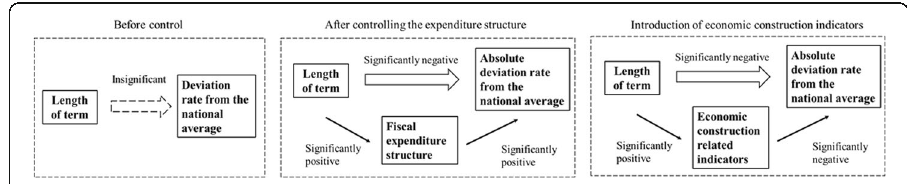
Fig. 6 Analysis of the impact mechanism of expenditures on science, education, culture, and